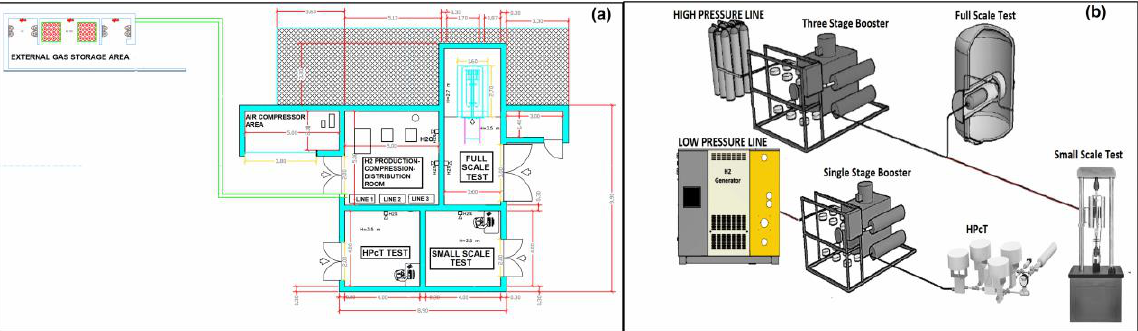
Figure 1. ( a ) Δ H Lab map, ( b ) Δ H Lab gas lines. Figure 1. ( a ) ∆ H Lab map, ( b ) ∆ H Lab gas